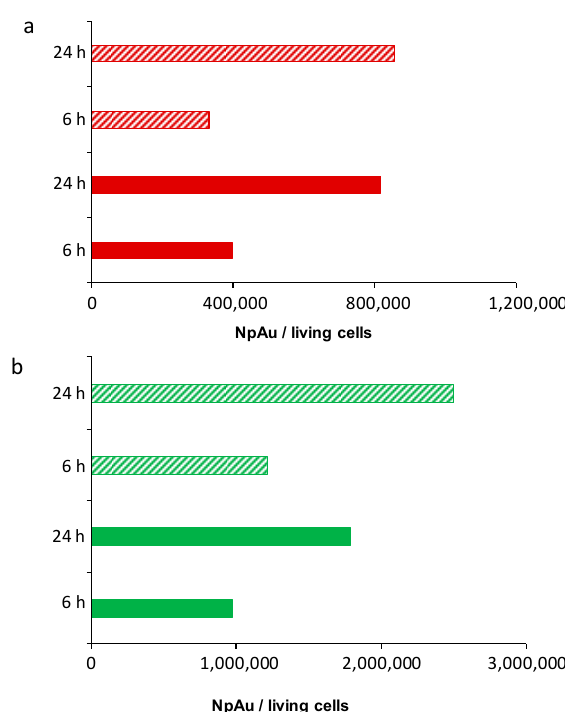
Figure 7. Inductively coupled plasma-optical emission spectrometry (ICP-OES) analyses of ( a ) HeLa and ( b ) U87 MG cells incubated with Au@DTDTPA (filled bars) and Au@DTDTPA-Cy5 (dashed bars) nanoparticles for 6 and 24 h.